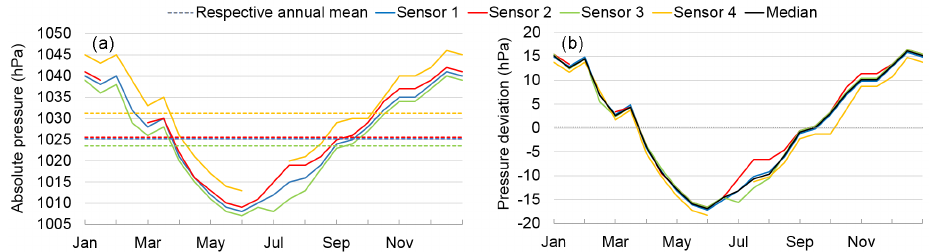
Figure 2. Schematic illustration for handling an annual data set of a four-sensor array. Different pressure at the various sensors (a) can result from the calibration or from different altitudes since the arrays have an aperture of 1–3km (Evers and Haak, 2010). Here, temporarily missing data for sensors 2 and 4 are without significant consequence when deriving the median (b) as time series for a multi-sensor station.